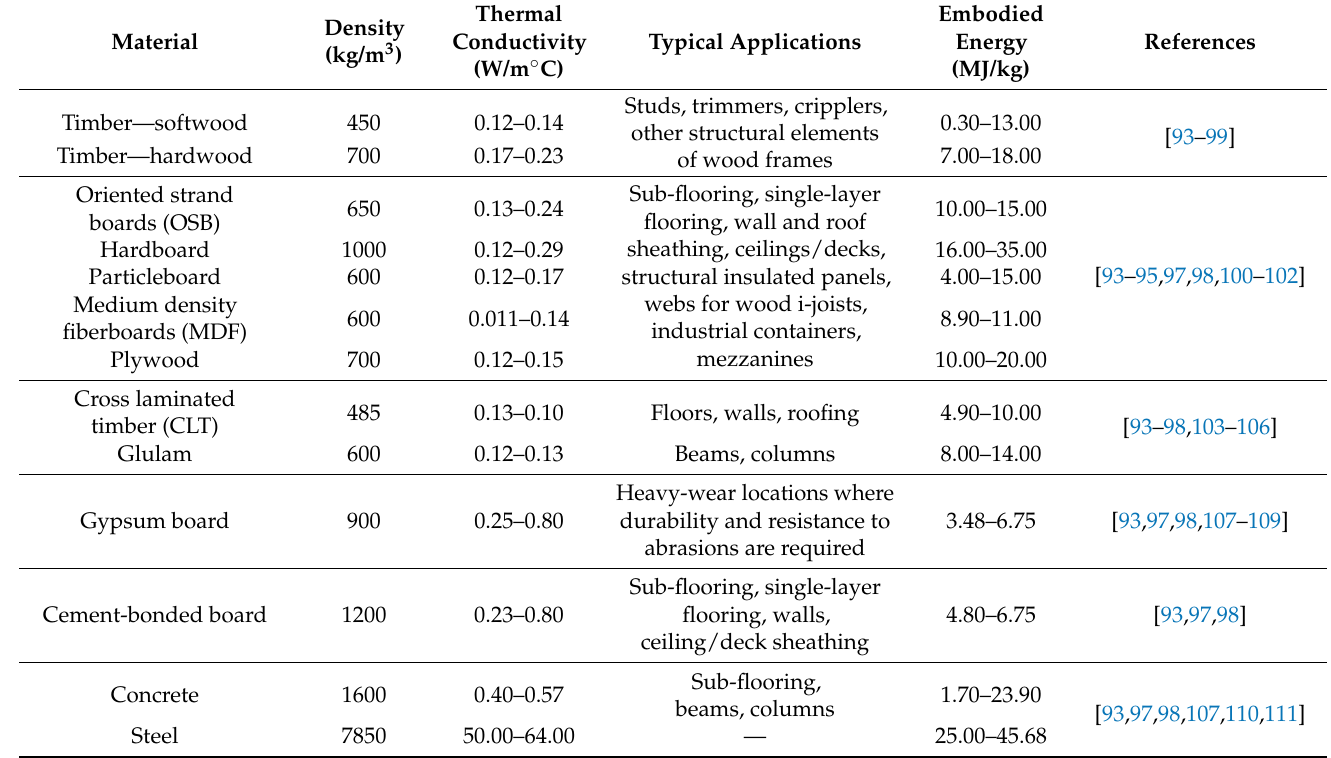
Table 3. Thermal characteristics and embodied energy of commonly used building